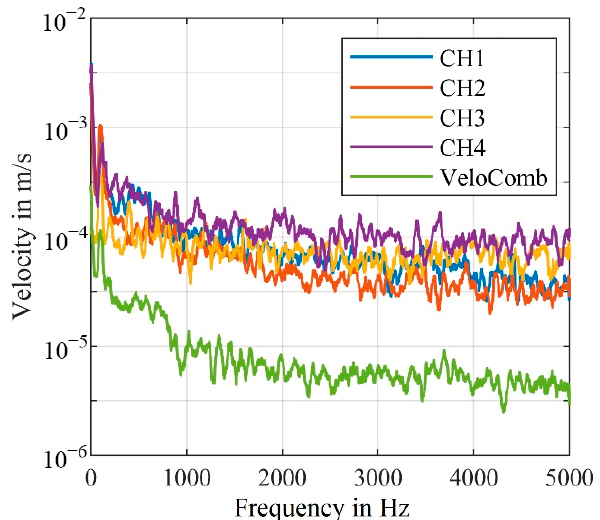
Figure 4. Frequency spectra of the velocity signals shown in Figure 3 (smoothed for better visualization); (RBW = 2.5 Hz).